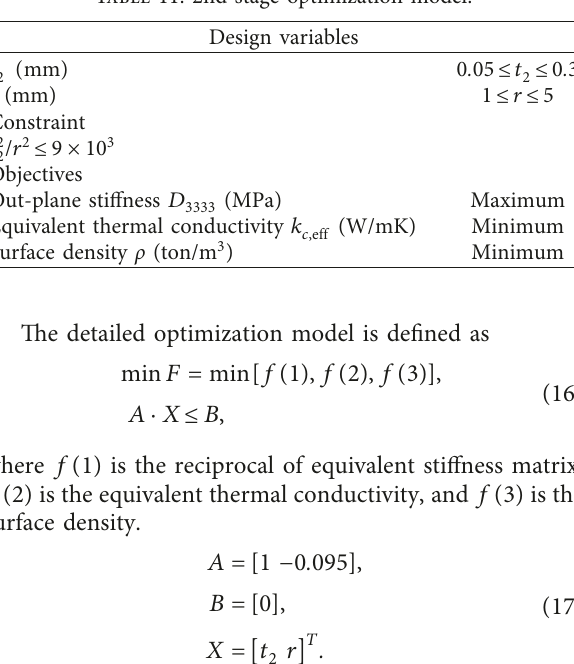
Table 11: 2nd stage optimization model. Table 12: Pareto optimal solution